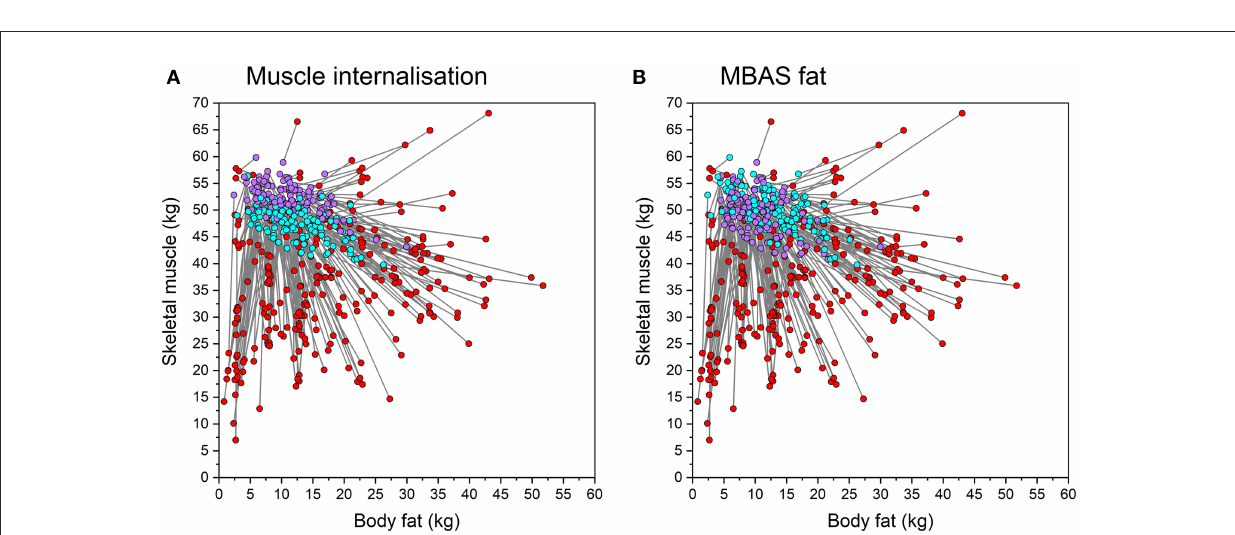
FIGURE4 Vector plots of “current” estimate of body composition (red circles) and ideal body composition predicted from the multivariate multiple regression model in Table 4. The lines connect each individual participant’s “current” belief to their ideal. The ideal points are split into two distributions based on their psychometric score. (A) Ideal body composition data points from individuals with a SATAQ muscle internalization score below the sample median are color coded in cyan, above the median in violet. (B) Ideal body composition data points from individuals with a MBAS fat score below the sample median are color coded in cyan, above the median in